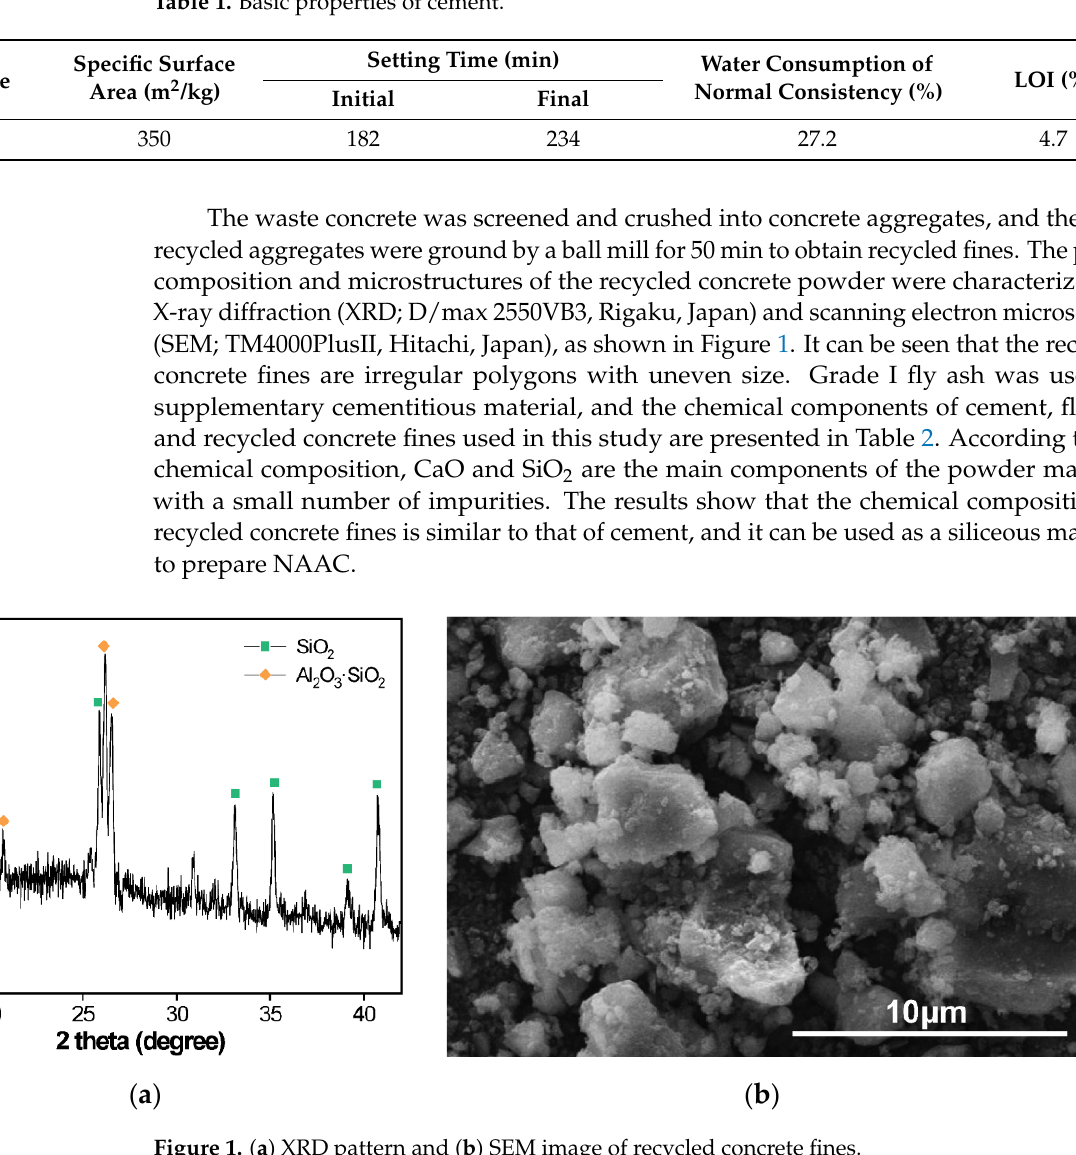
Table 1. Basic properties of cement.